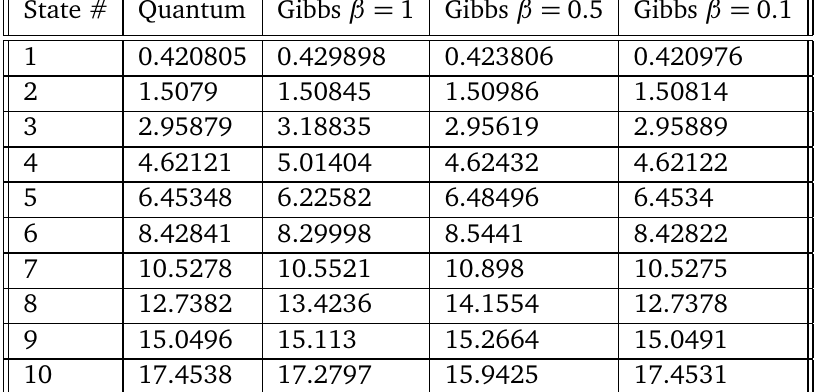
Table 1: Comparisons of energies of the first 10 eigenstates corresponding to a particle in a quartic potential. The first column corresponds to the exact quantum energies. The next three columns are the energies of the classical eigenstates ob- tained from the Gibbs distribution at three different temperatures. The parameters are the same as in Fig. 2. State # Quantum Gibbs β = 1 Gibbs β =